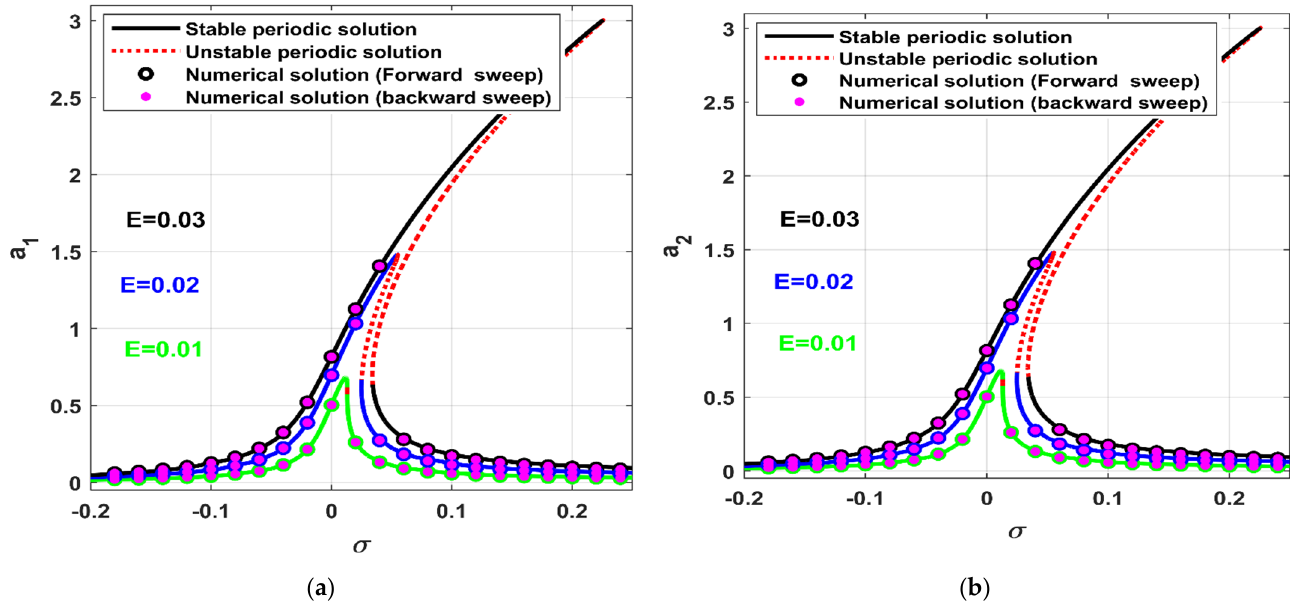
Figure 4. σ —response curve of the uncontrolled Jeffcott rotor at various values of the shaft eccentricity E : ( a ) oscillation amplitude in X —direction ( a 1 ) versus σ , and ( b ) oscillation amplitude in Y —direction ( a 2 ) versus σ